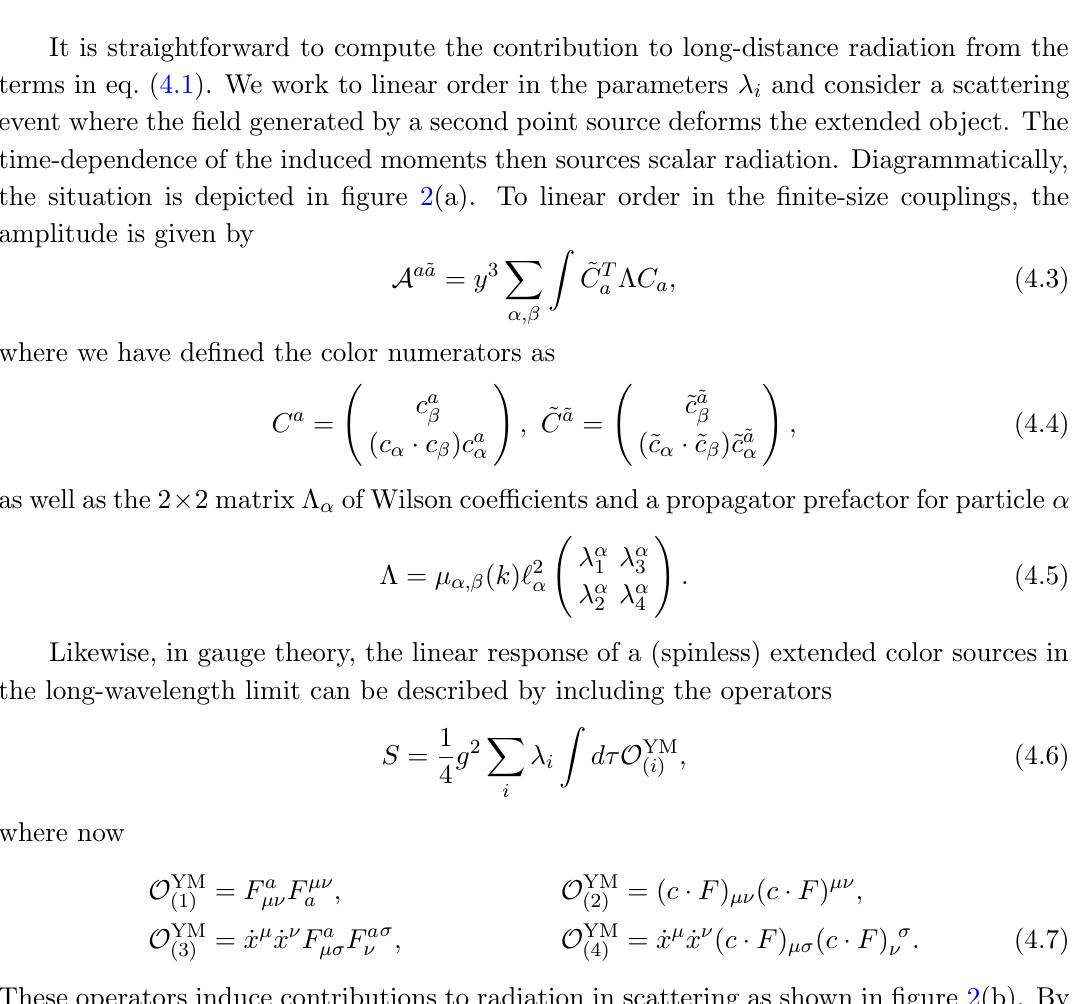
Figure 2 . The leading order diagrams for bi-adjoint and Yang-Mills radiation amplitudes induced by (cid:12)nite-size worldline operators, (a) for bi-adjoint scalar and (b) for